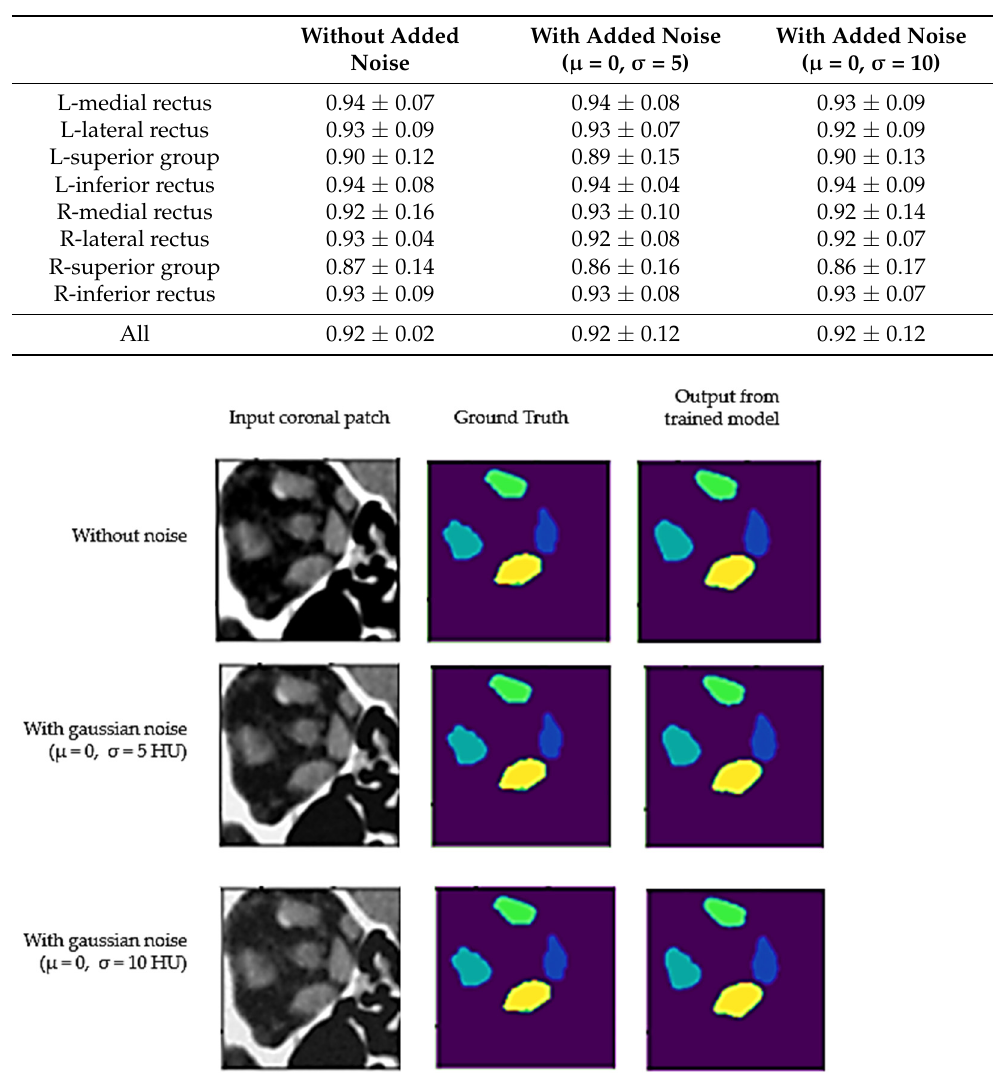
Figure 7. Output from the trained U-net on sample coronal patch where input image has been added with different levels of Gaussian noise (with mean μ and standard deviation σ ).